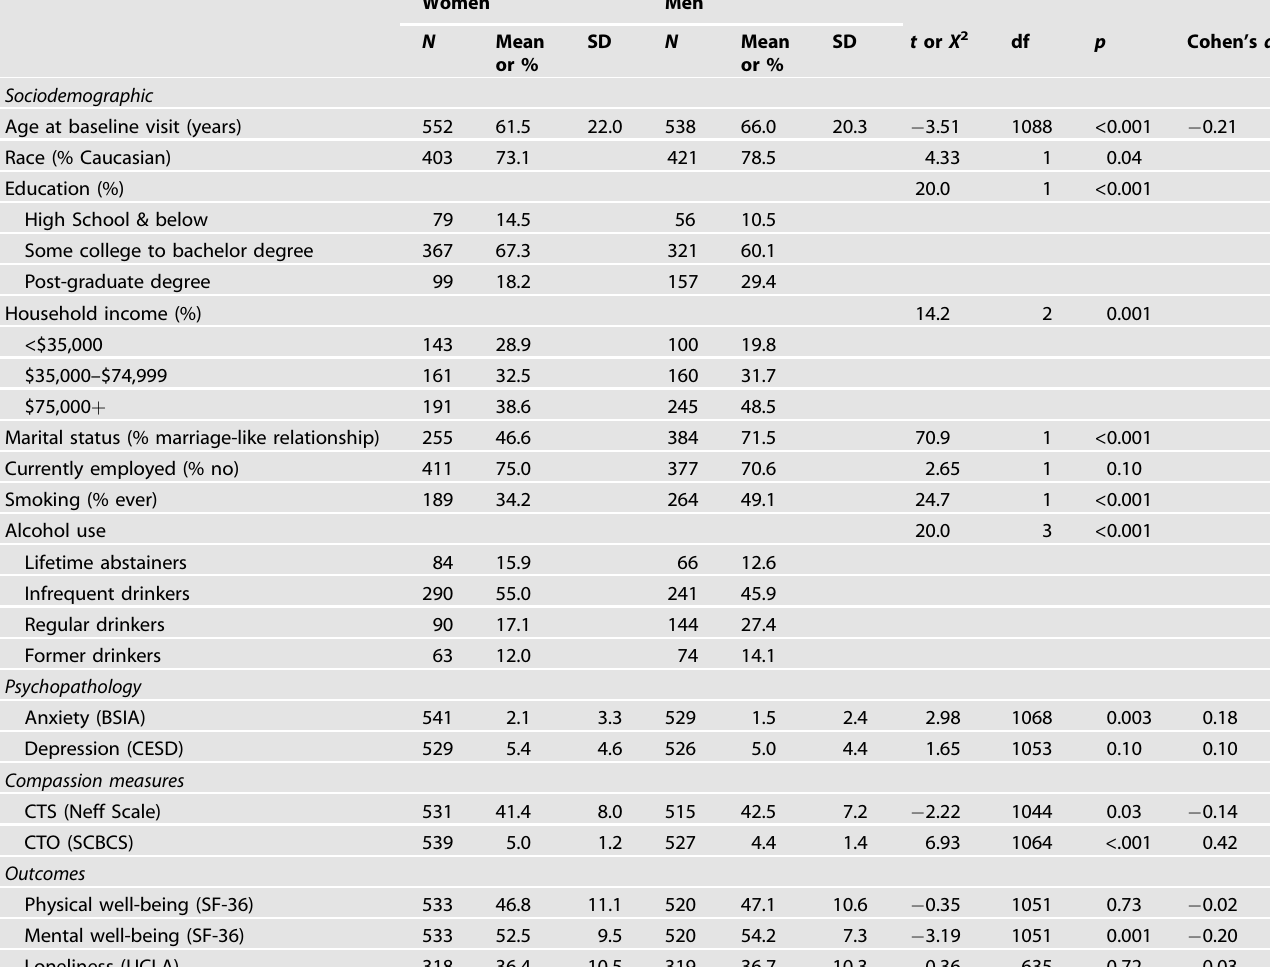
Table 1. Baseline demographic and clinical comparison of women and men in the study